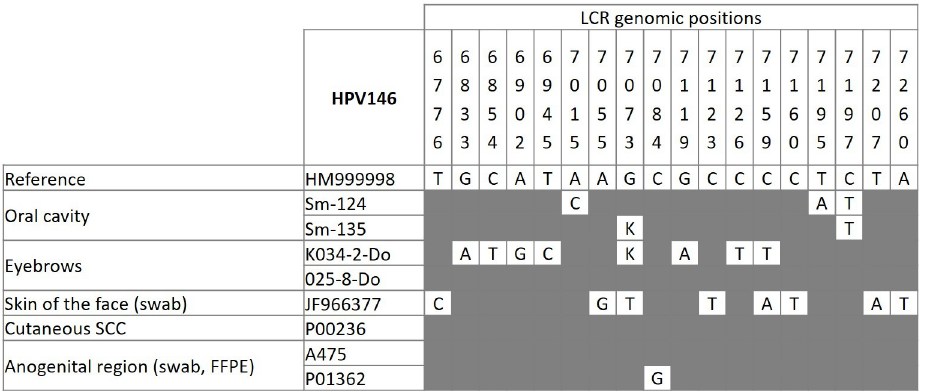
Fig 3. Long control region viral variants of human papillomavirus type 146 in eight independent samples obtained from immunocompetent individuals (GenBank acc. nos. MW574246 –MW574252 and JF966377). The top of the frequency table shows the nucleotide sites of substitutions in HPV146 isolates investigated according to the HPV146 reference genome. Nucleotide sites where no substitutions or deletions were observed are marked gray. � The viral variants consist of at least two variants of the LCR genomic region; degenerate bases (wobble) by IUB: K (G/T).